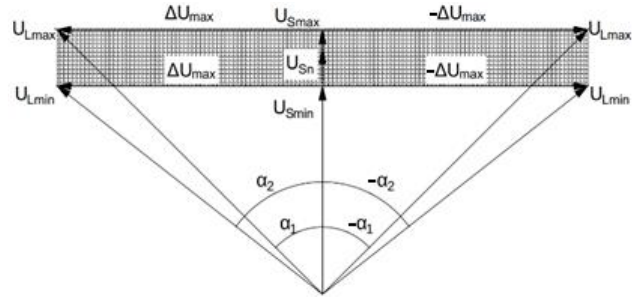
Figure 6. The laboratory ACPST phasor diagram for all control possibilities. The ACPST can be used as a normal transformer with only longitudinal voltage regulation ( ∆ U = 0). For the chosen values of the ACPST, the output parameters are presented in Table 2.